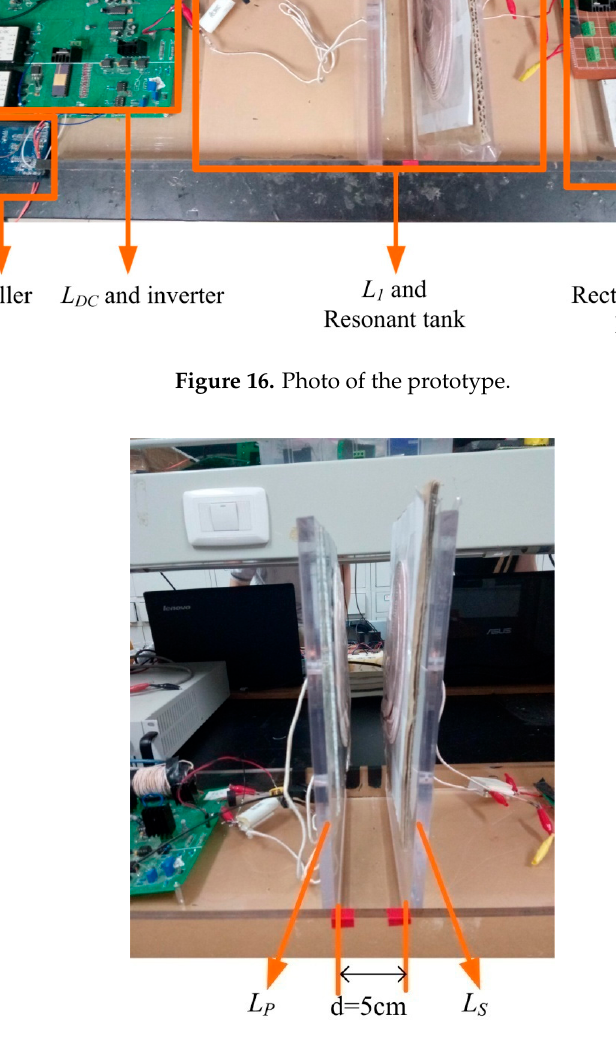
Figure 17. The coupling structure.